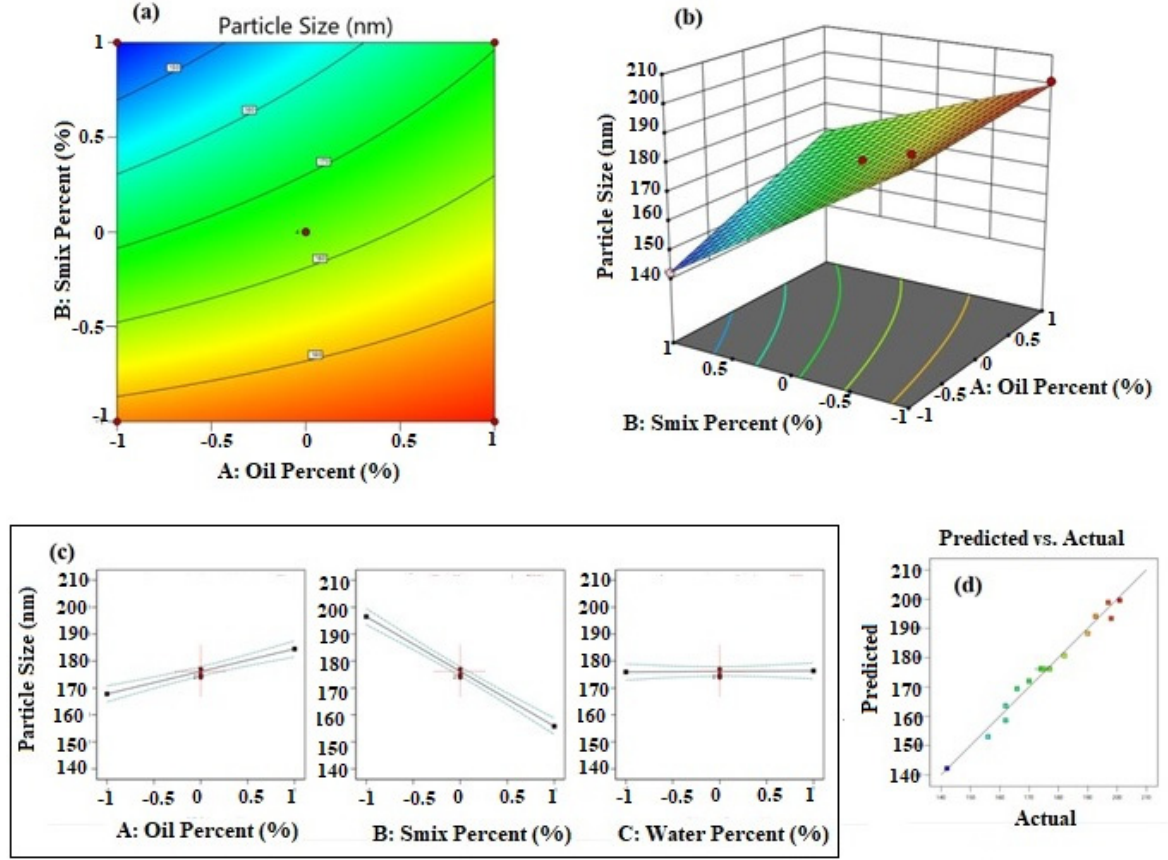
Figure 1. Results of analysis of data of particle size; ( a ) contour plot, ( b ) response surface plot, ( c ) individual factor effects, and ( d ) predicted versus actual plot. Table 5. ANOVA data for PDI of ETB-NE formulations.